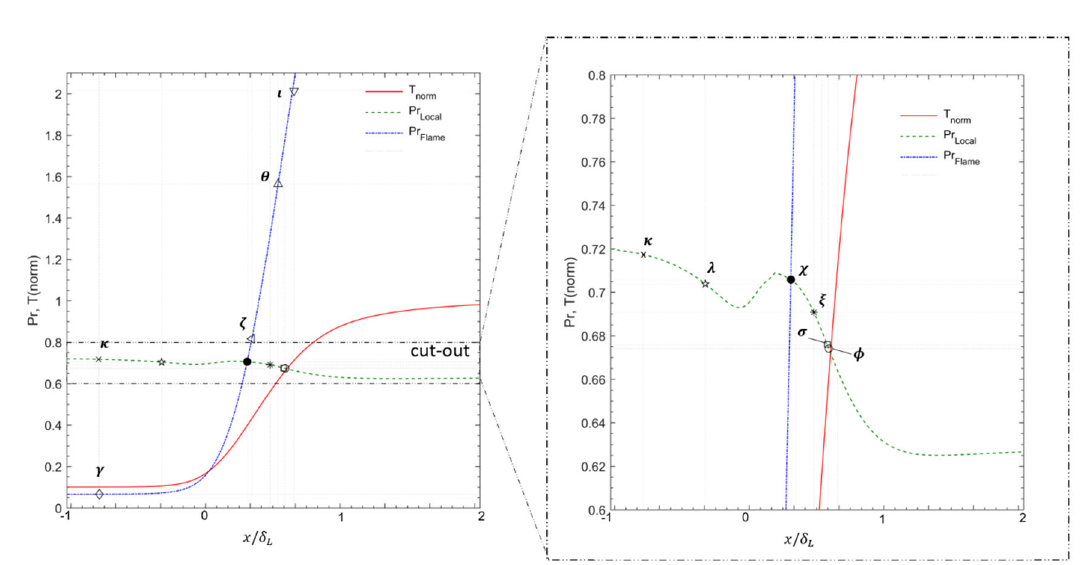
Figure 8. Pr development throughout the flame front. T is normalised with T max . Pr Local is de- termined according to Equation (12). Pr Flame is determined according to Equation (9). “Cut-out” indicates the magnified area. Conditions: Stochiometric O 2 /CH 4 mixture at 20 bar and initial temper- ature of 350 K. The upper range of the blue line of Pr Flame , where it converges to a stable value, is cut out due to its irrelevance to the current